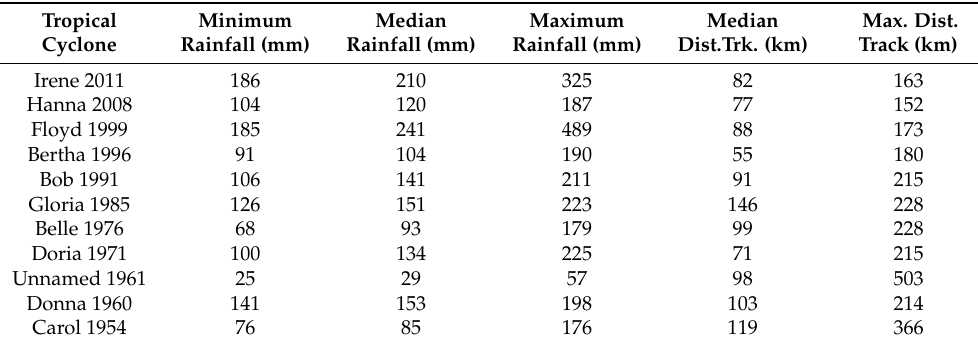
Table 2. Minimum, median, and maximum, values for storm total rainfall and distance to track for top 10% of rainfall totals left of